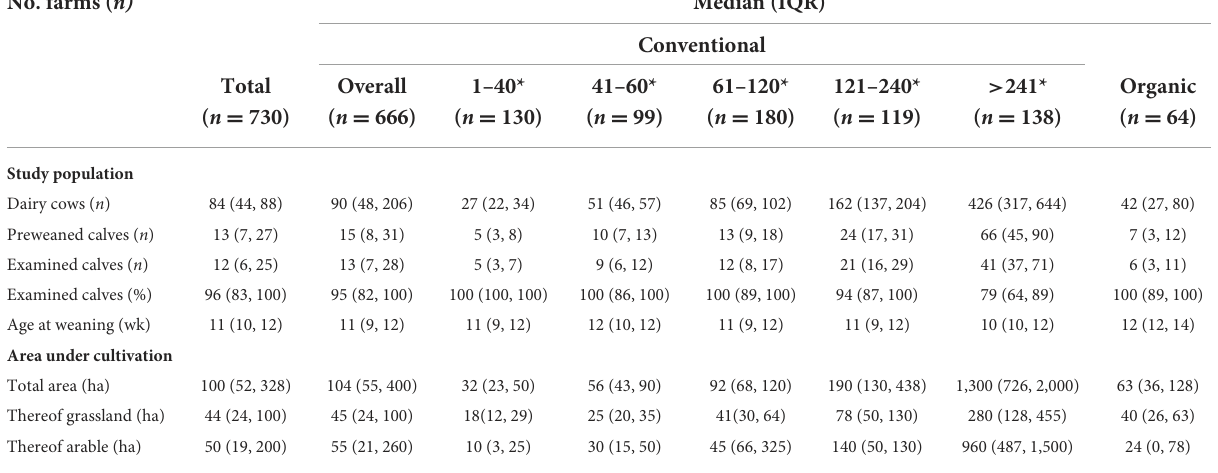
TABLE 1 Study population and farm data for 730 dairy farms in Germany stratified by herd size and farm type. No. farms (